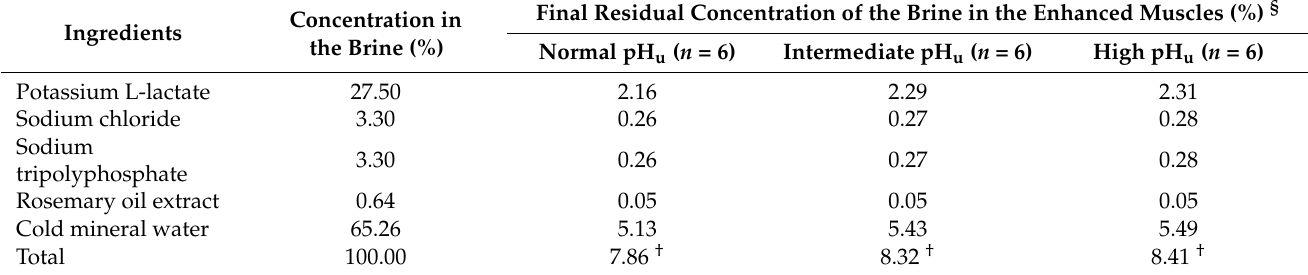
Table 1. Brine composition and final residual concentration of each compound in enhanced muscles per ultimate pH (pH u ) range.